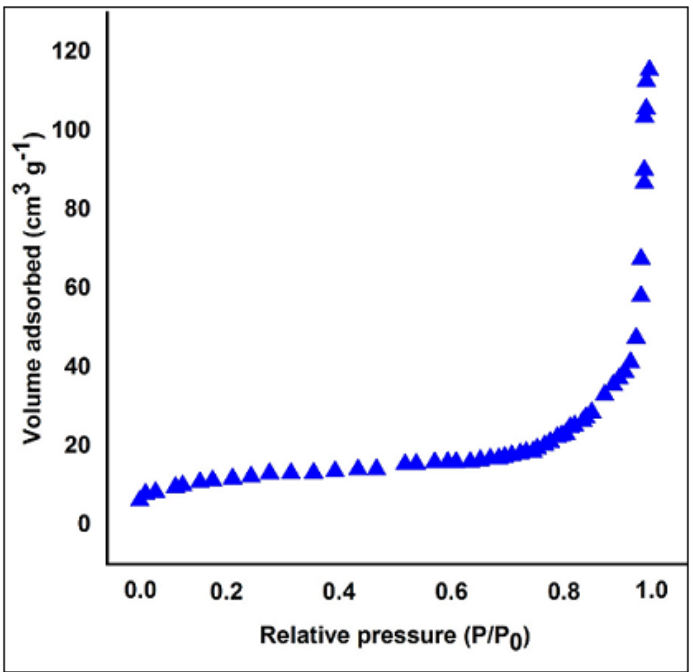
Figure 4. Nitrogen adsorption isotherm of PANI–MoS 2